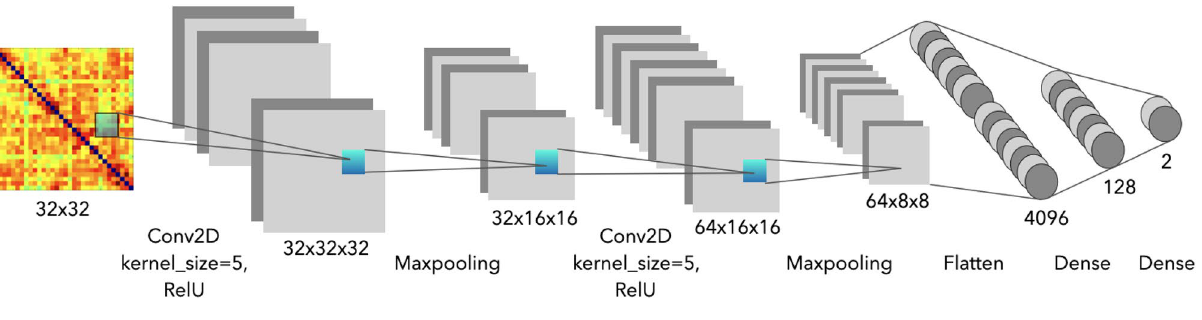
Figure 9. The structure of proposed network